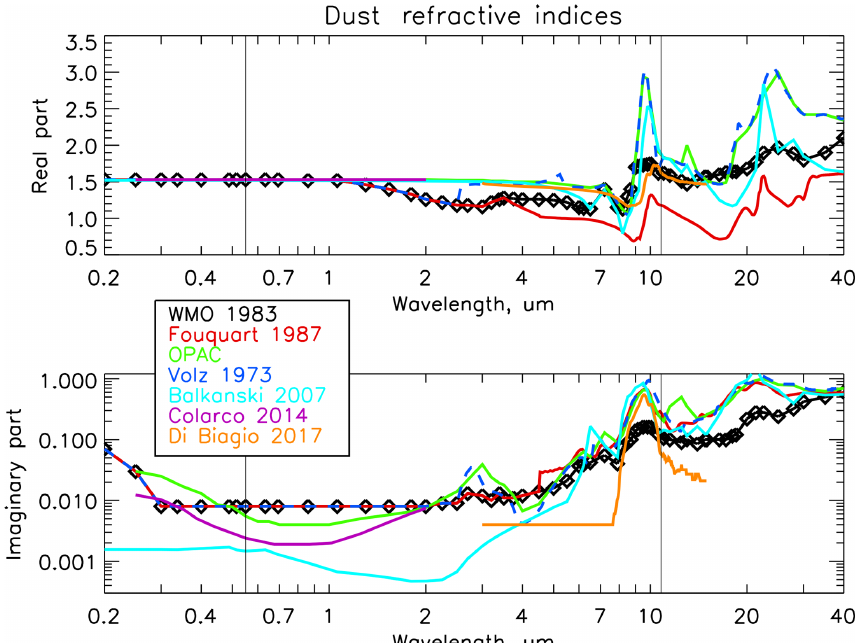
Figure 3. Dust spectral refractive index datasets from the literature. Vertical lines indicate wavelengths of 0.55 and 10.8µm. See the text for dataset descriptions. Partial lines only provide a subset of spectral refractive